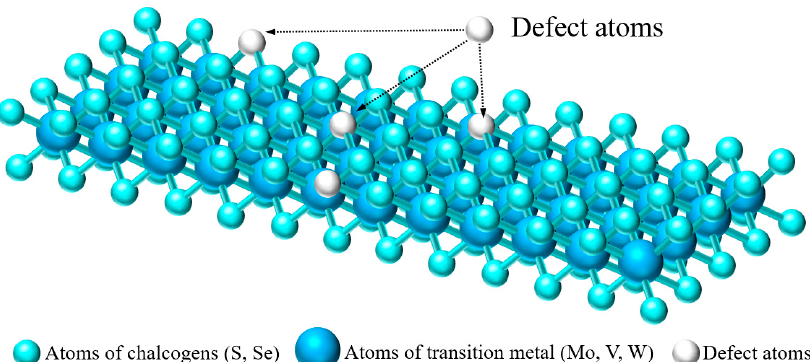
Figure 3. Defect atoms in TMDs singer layer.